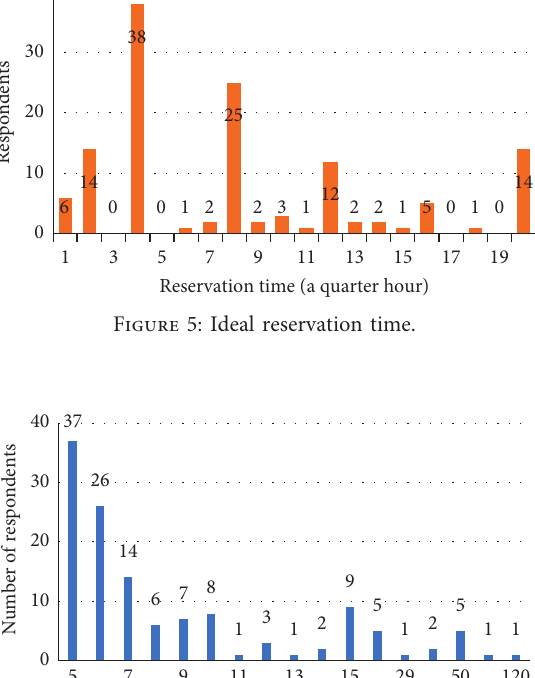
Figure 10: Reservation fee under four